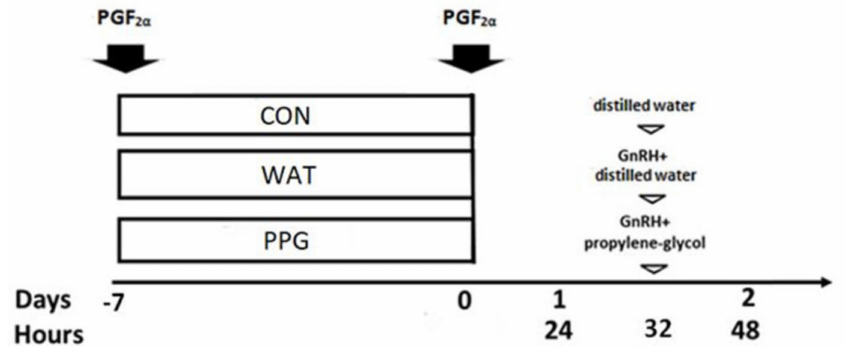
Figure 1. Experimental groups of trial 1, aiming to determine the e ff ect of gonadotrophin-releasing hormone (GnRH) administration in either distilled water or propylene-glycol on the ovarian response to prostaglandin-based protocols. All females were treated with two doses of prostaglandin F 2 α (PGF 2 α ) 7 days apart and, 32 h after injecting the second dose, they received either 5 mL of distilled water (group CON, n = 6) or 1 mL of Acegon (50 µ g of GnRH) in either i.m. distilled water (group WAT, n = 6) or i.m. 4 mL of propylene-glycol (group PPG, n =